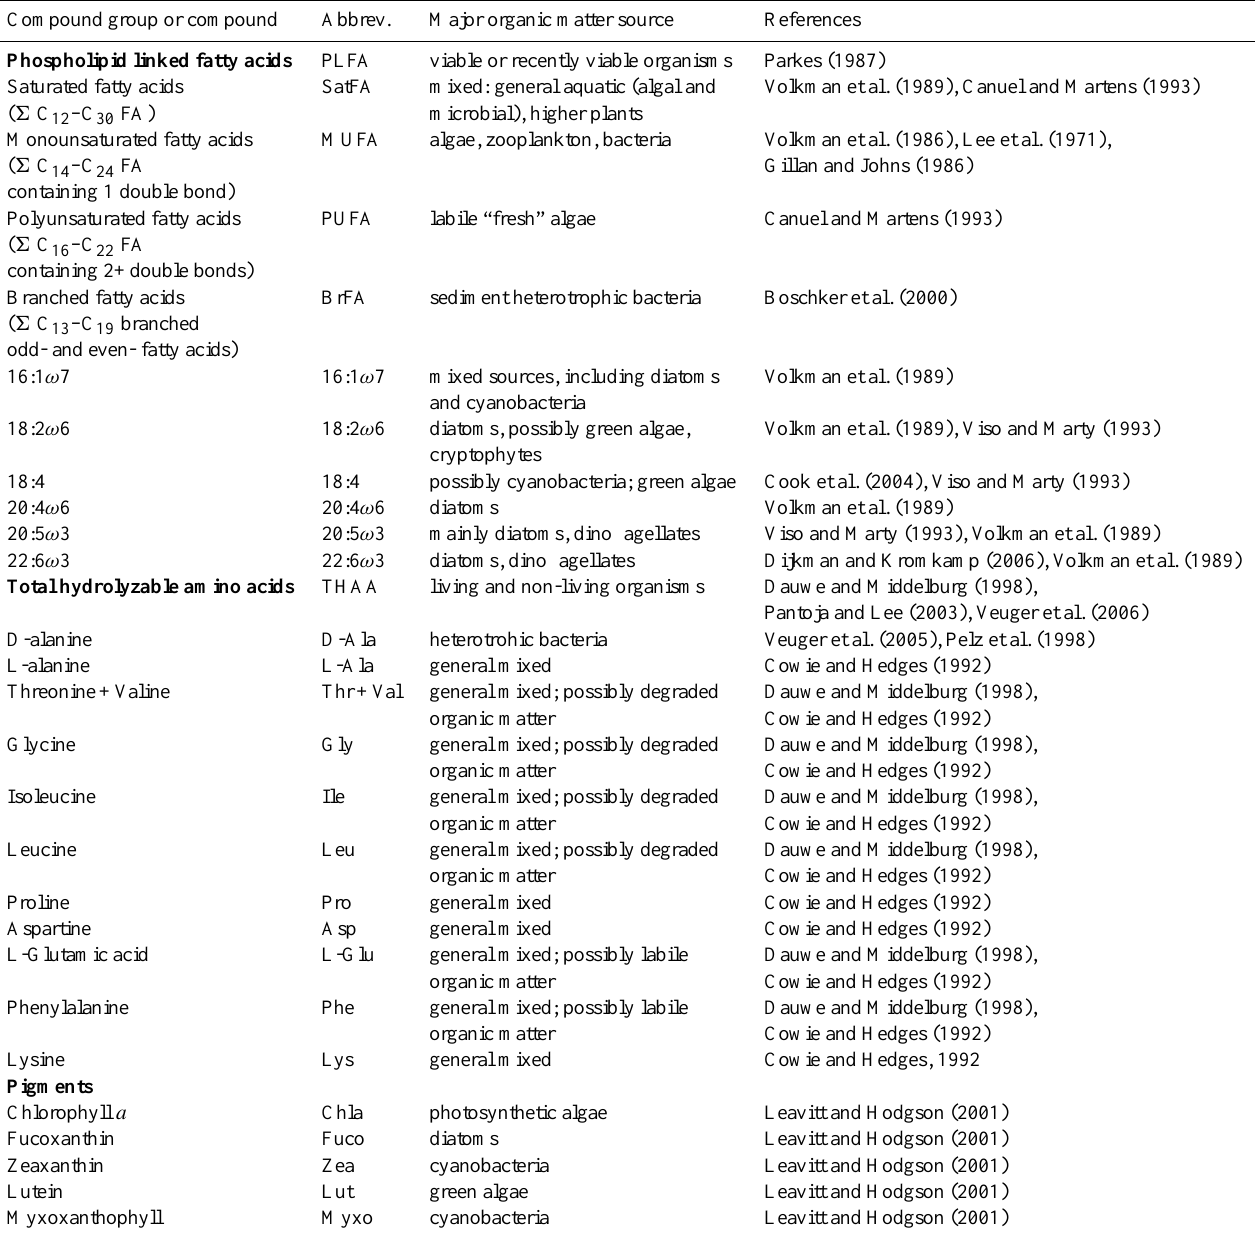
Table 1. Specific biomarkers, abbreviations, and major organic matter sources used in this study.